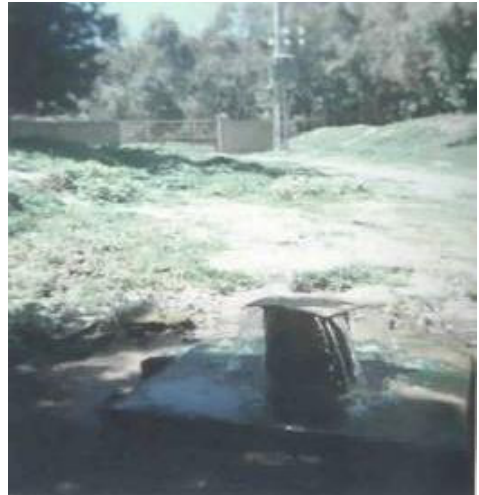
Figure 10. A pressurized borehole located downstream from the dike of Hammam Grouz